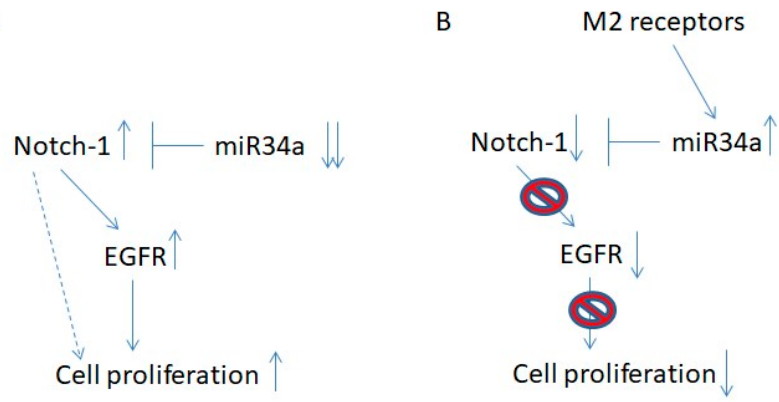
Figure 8. Schematic representation of the Notch-1/EGFR axis in U87 cells. ( A ) In U87 cells, the downregulated expression of mir-34a-5p caused the up-regulation of Notch-1 expression with consequent increased expression of EGFR. The up-regulation of these two receptors causes increased cell proliferation. ( B ) M2 muscarinic receptors up-regulate the expression of mir-34a-5p, which prevents the increased levels of Notch-1. The down-regulation of Notch-1 negatively affects cell proliferation by the down-regulated expression of EGFR.